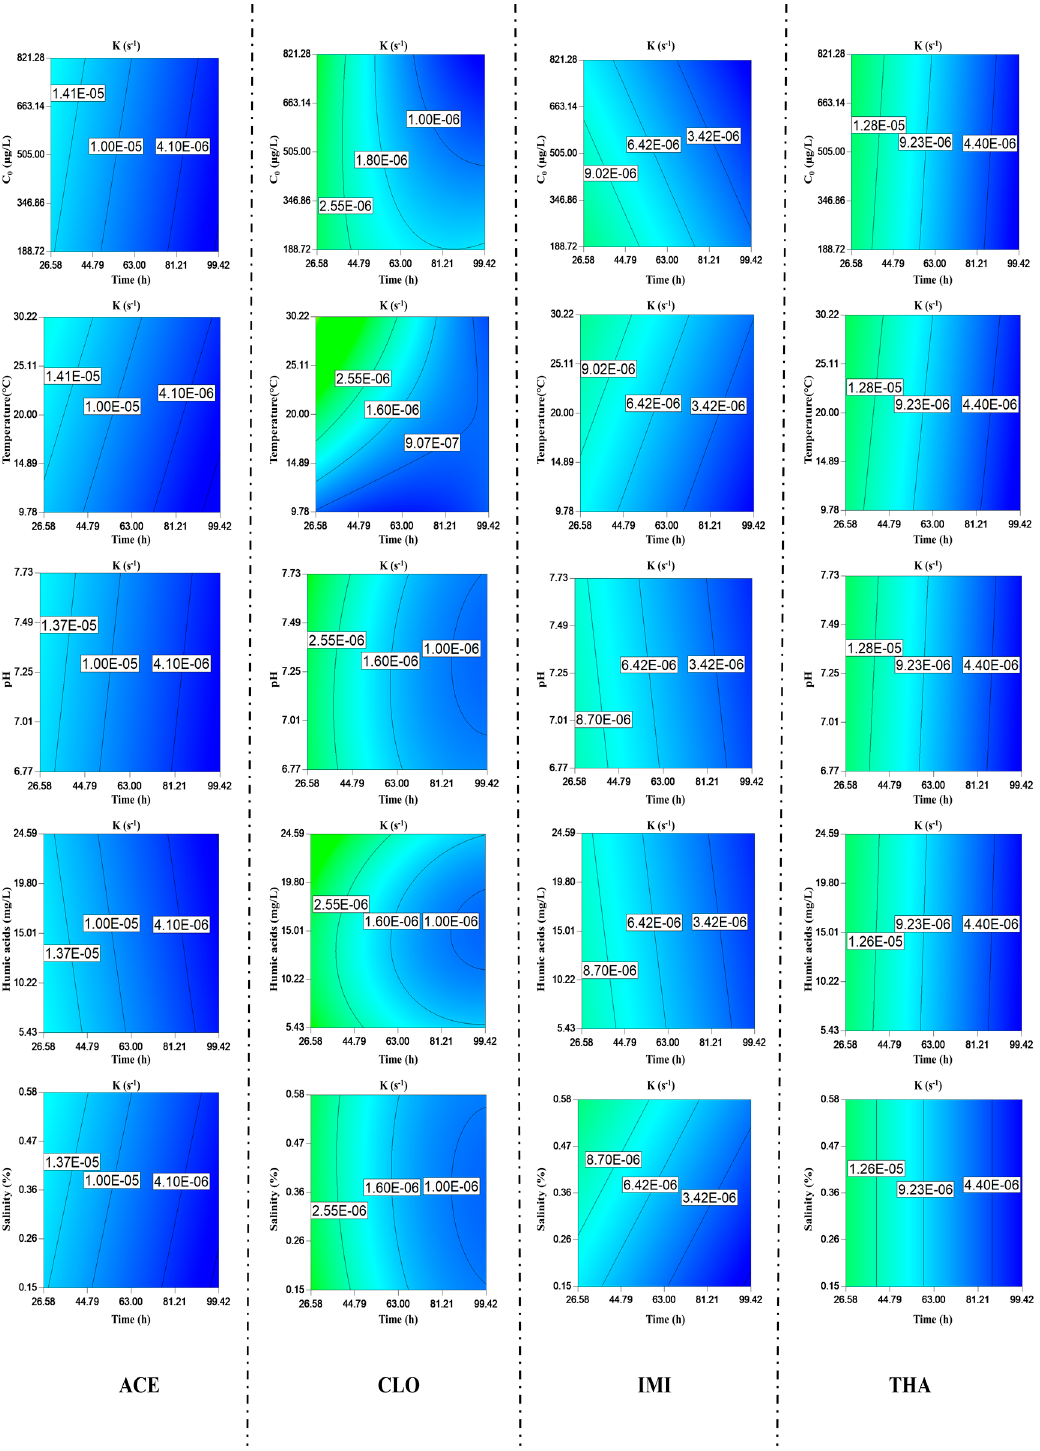
Figure 2. Hydrolysis of four typical NEOs and environment parameters affecting NEO hydrolysis Other environmental parameters also affected the hydrolysis processes of some NEOs. Salinity seemed to promote the hydrolysis of ACE and IMI. With the increase in salinity, IMI and ACE hydrolysis rates increased by 10% and 5%, respectively. There were no apparent effects of the salinity on the hydrolysis rates of CLO and THA. Humic acids imposed a slight enhancement effect on the hydrolysis of THA but inhibited that of IMI